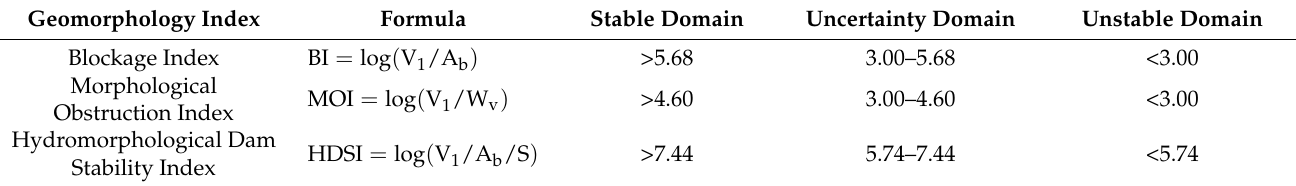
Table 2. Geomorphic index evaluation methods.